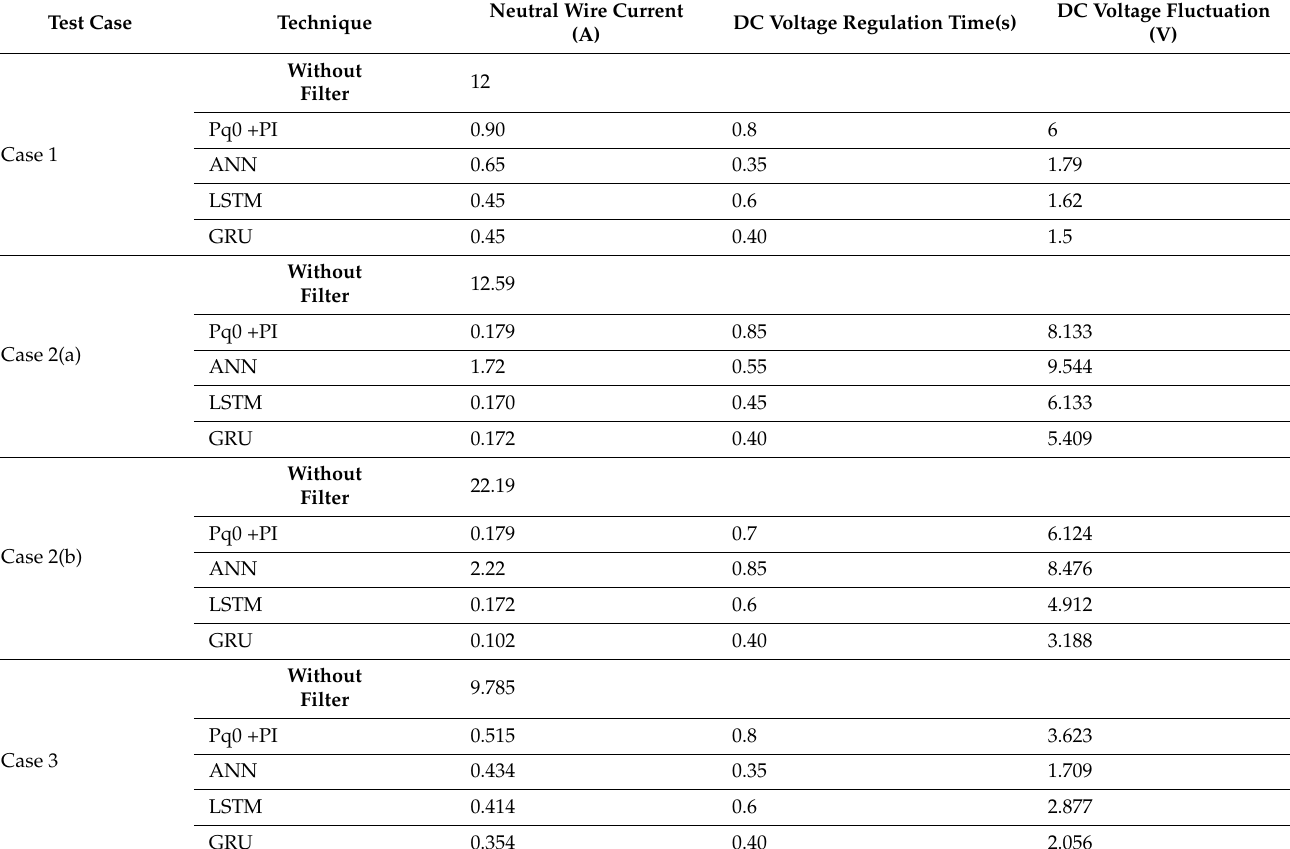
Table 6. Algorithms’ performance for neutral wire current and DC voltage